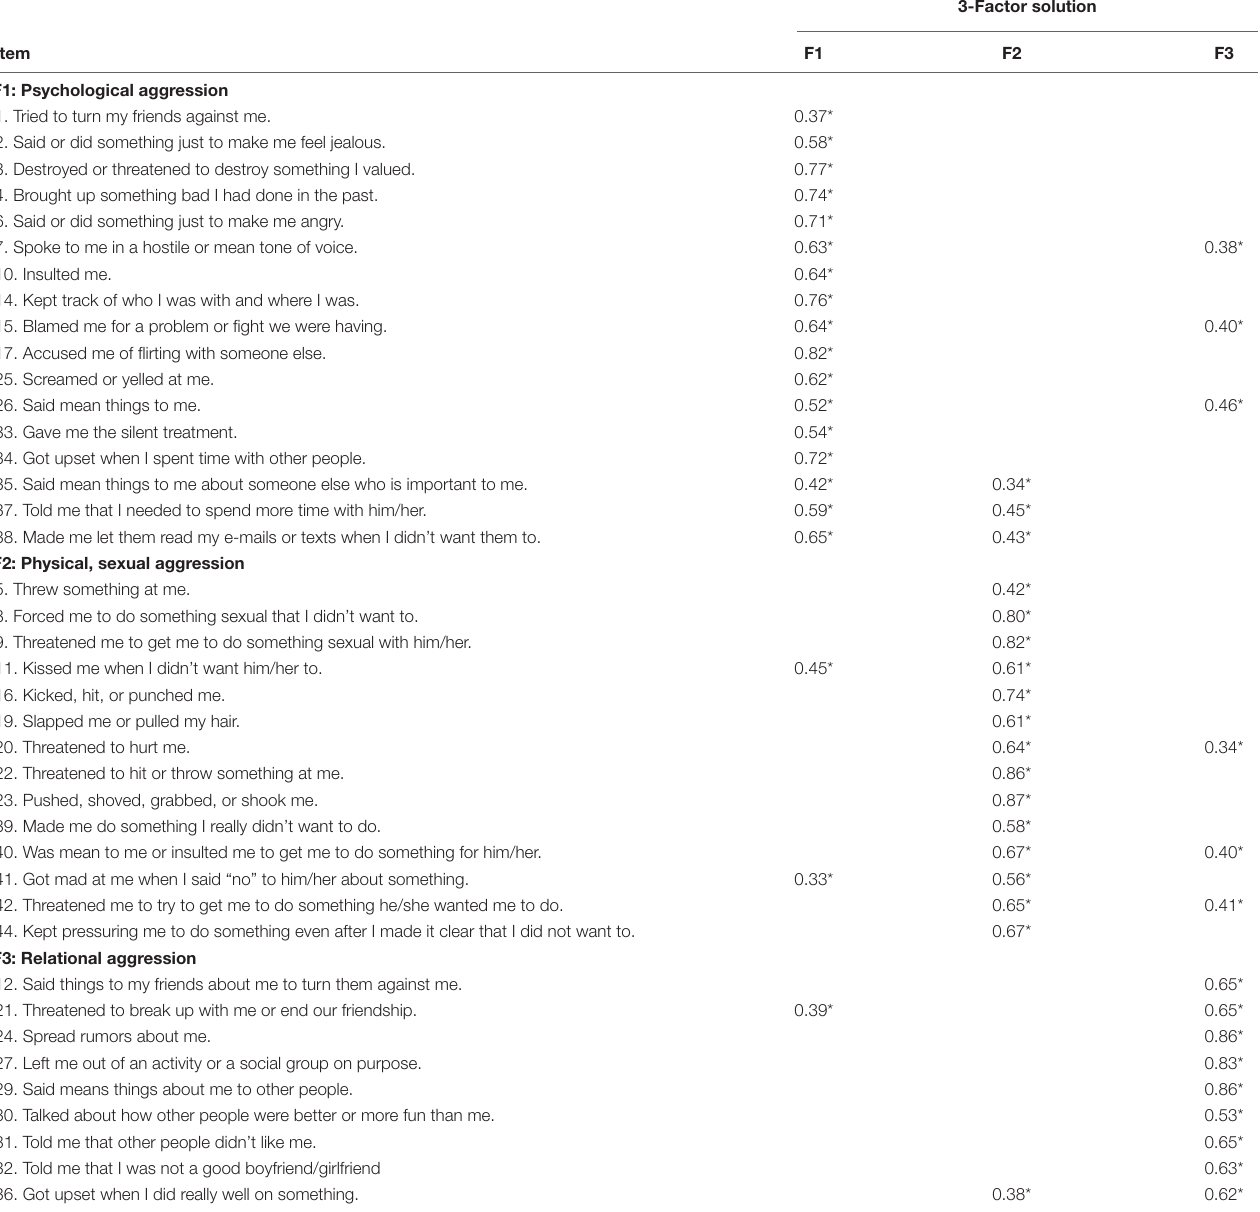
TABLE 4 | Standardized factor loadings and descriptive statistics for the 3-factor solution of the Teen Dating Aggression Measure